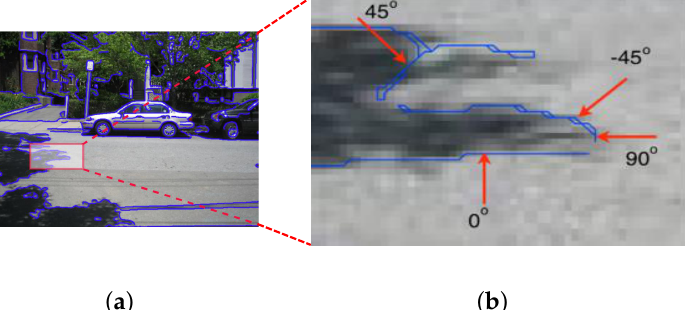
Figure 3. ( a ) Boundaries detected with threshold values of 0.08, 0.2 and standard deviation of the Gaussian filter σ = 3. As an example, the red rectangle indicates an area of interest which shows four directions of boundaries. ( b ) Shadow boundaries with four possible directions for the local region of interest.